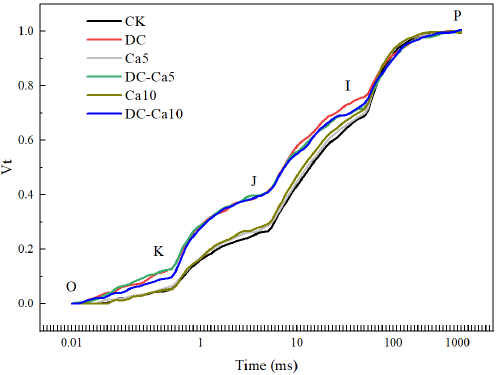
Figure 4. Relative variable fluorescence of Pinus sylvestris var . mongolica exposed to well water (WW), water stress (WS), and different calcium (Ca) concentrations. The relative variable fluorescence was a double normalization of the Chl a fluorescence transient at Fo and Fm and was calculated as Vt = (Ft − Fo)/(Fm − Fo). Table 1. The parameters derived from the chlorophyll fluorescence curve. Sm = Area/F V , the normalized total complementary area above the O-J-I-P transit; V J and V I are relative variable fluorescence at the J-step and I-step, respectively; Mo = 4 (F300 µ s − Fo)/(Fm − Fo), the approximated initial slope of the fluorescence transient.